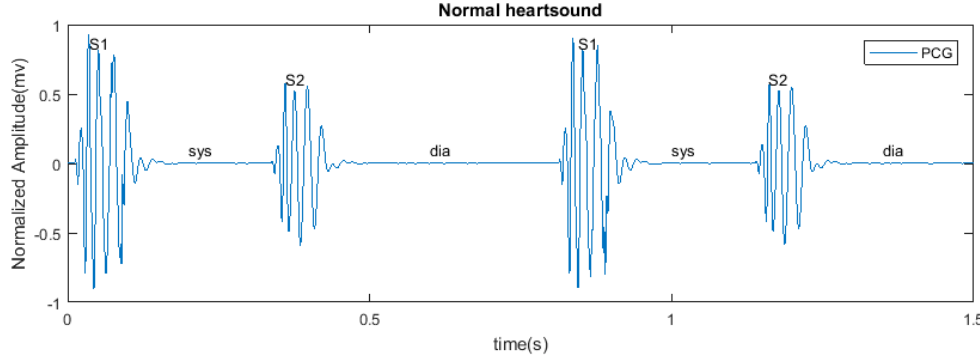
Figure 1. An example of a normal heart sound includes two heart sound cycles, and each cycle consists of the following heart sound components: S1, sys, S2, and dia.